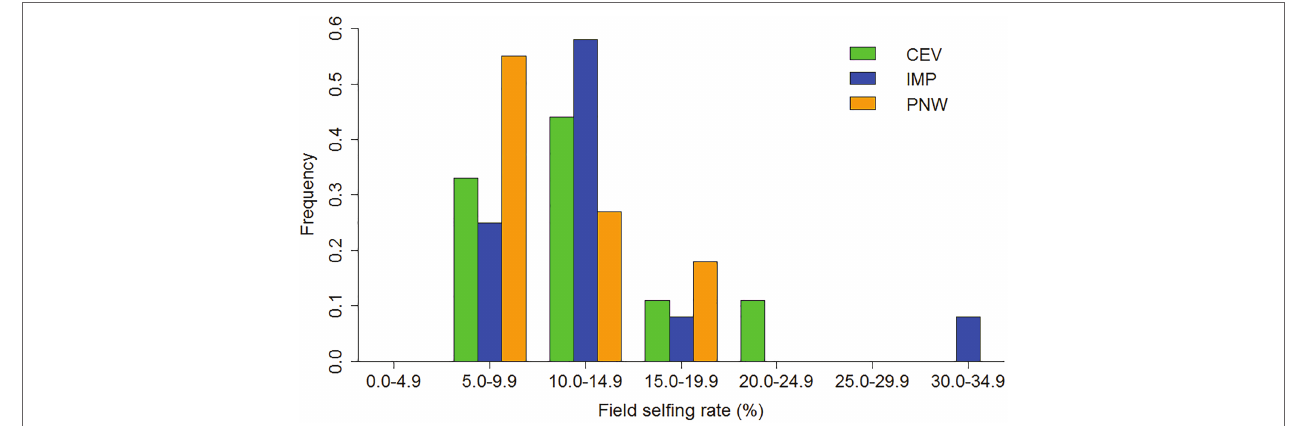
FIGURE 1 | Frequency distribution of field selfing rates in three regions of alfalfa seed production. The regions are the Central Valley of California (CEV, N = 9 fields), the Imperial Valley of California (IMP, N = 12 fields), and the Pacific Northwest (PNW, N = 11